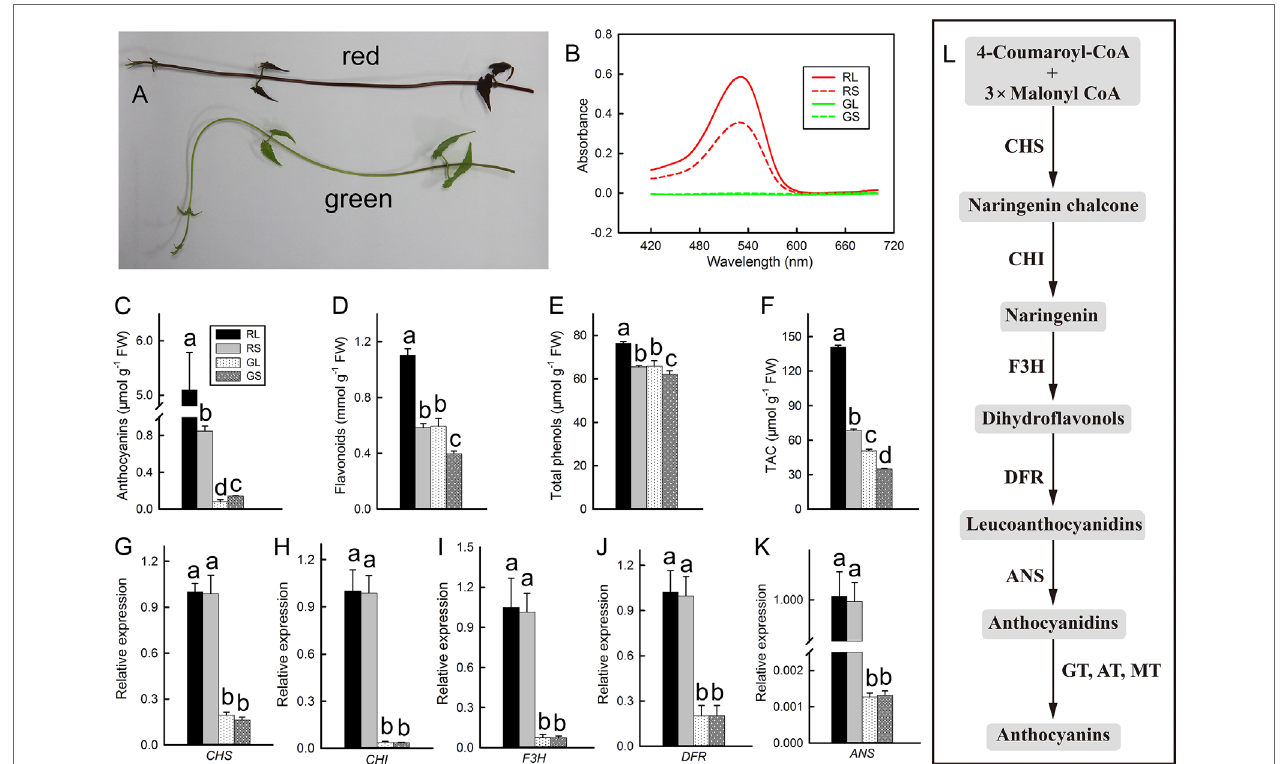
FIGURE 1 | Phenotypes of different-colored M. micrantha (A) . Absorbance spectra of anthocyanin extracts from red leaves (RL), red stems (RS), green leaves (GL), and green stems (GS) of M. micrantha (n = 5) (B) . Contents of anthocyanins (C) , flavonoids (D) , and total phenols (E) and the total antioxidant capability (F) in the RL, RS, GL, and GS of M. micrantha (n = 8). Relative expression of the anthocyanin biosynthetic pathway genes chalcone synthase ( CHS ), chalcone isomerase ( CHI ), flavanone 3-hydroxylase ( F3H ), dihydroflavonol 4-reductase (DFR), and anthocyanidin synthase ( ANS ) (G–K , respectively ) in the RL, RS, GL, and GS of M. micrantha (n = 6). The actin gene was used for normalization. The schematic picture of anthocyanin biosynthesis (L) . The error bars represent the standard errors (SEs) of five to eight biological replicates. One-way analysis of variance (ANOVA) was used to evaluate the statistical significance; the bars with different letters (a, b, c, d) indicate significant differences between the means (least significant difference, P <